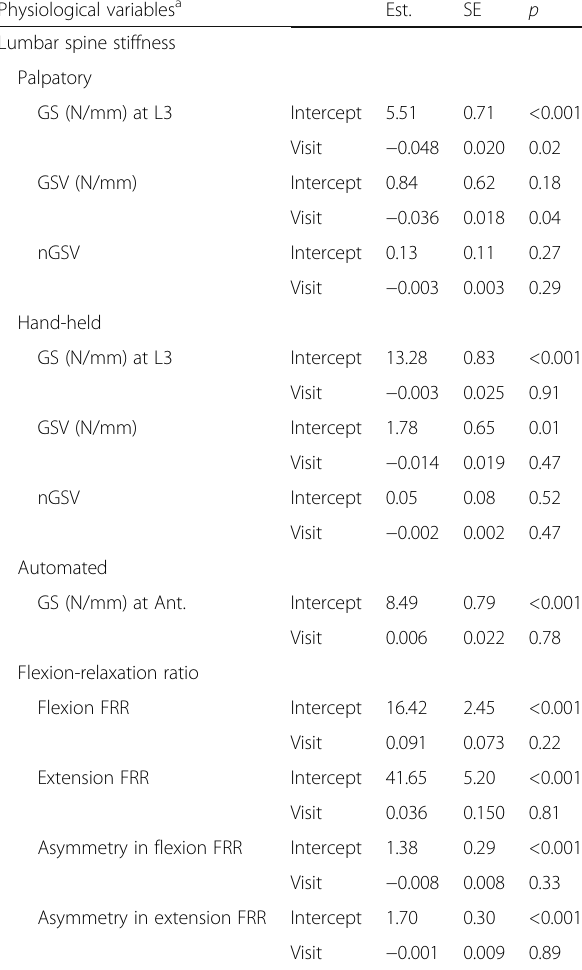
Table 4 Estimated regression coefficients from separate mixed-effects regression models of physiological covariates over time Physiological variables